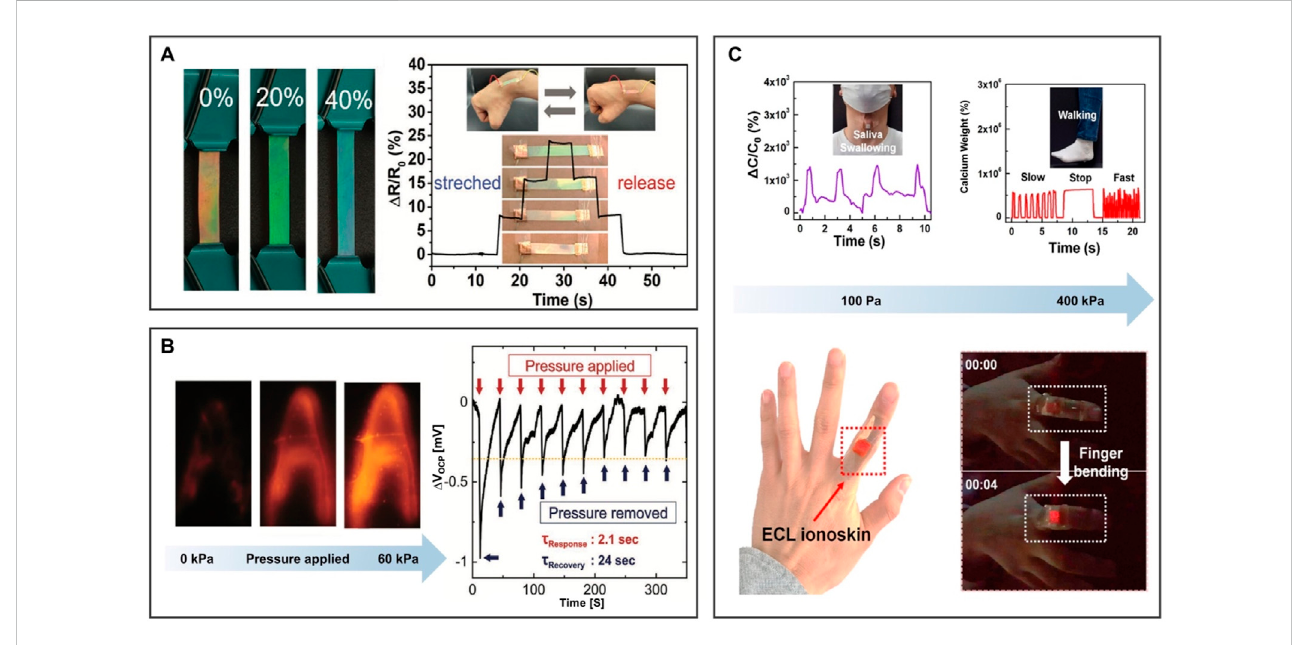
FIGURE 9 BILIMs forabiologicalsensor. (A) Bionicinteractivevisibleionskin.Reproducedwithpermission(Lyuetal.,2021).Copyright2021,Wiley-VCHGmbH. (B) Electrochemiluminescence skin with the piezoelectric ion effect. Reproduced with permission (Lee et al., 2021). Copyright 2021, Wiley-VCH GmbH. (C)